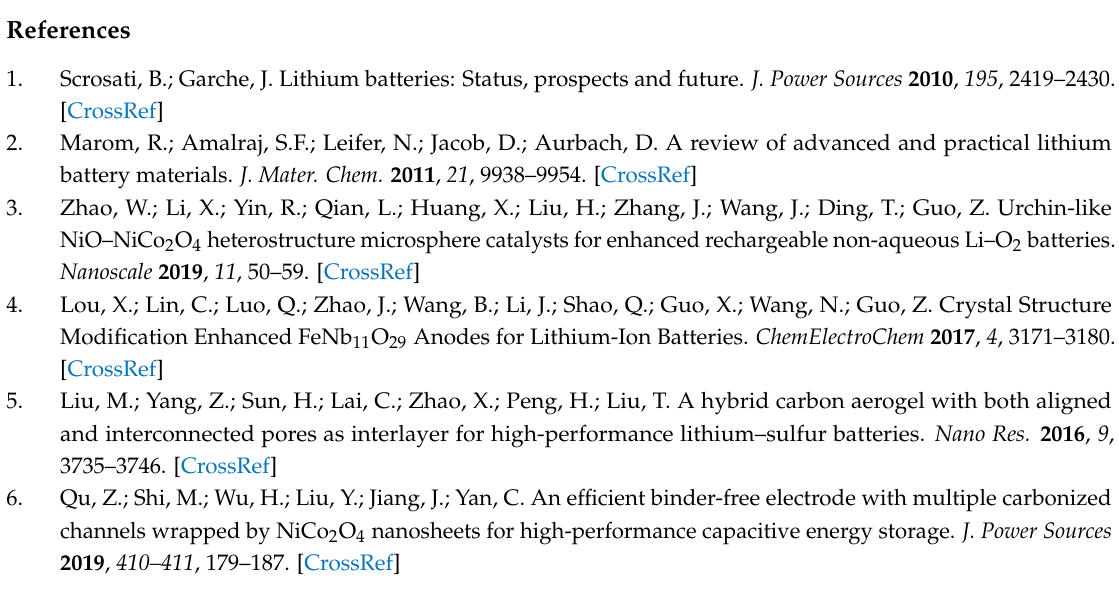
Figure S1: Thermogravimetric analysis for PFP polymer and V 2 O 5 ; Figure S2: GIWAXS 2-D images with ex situ thermal annealing from 25 ◦ C to 450 ◦ C for V 2 O 5 blended with (A) 5% PFO-F and (B) 2.5% CNTs; Figure S3: Images of peel tests; Figure S4: Galvanostatic charge–discharge tests for V 2 O 5 + 20%PFP; Figure S5: Galvanostatic charge–discharge tests for V 2 O 5 + 10% PVDF + 10% Super-P Carbon; Figure S6: Cyclic voltammetry for (a) pure V 2 O 5 and (b) 5% PFP + V 2 O 5 annealed from 150 ◦ C to 450 ◦